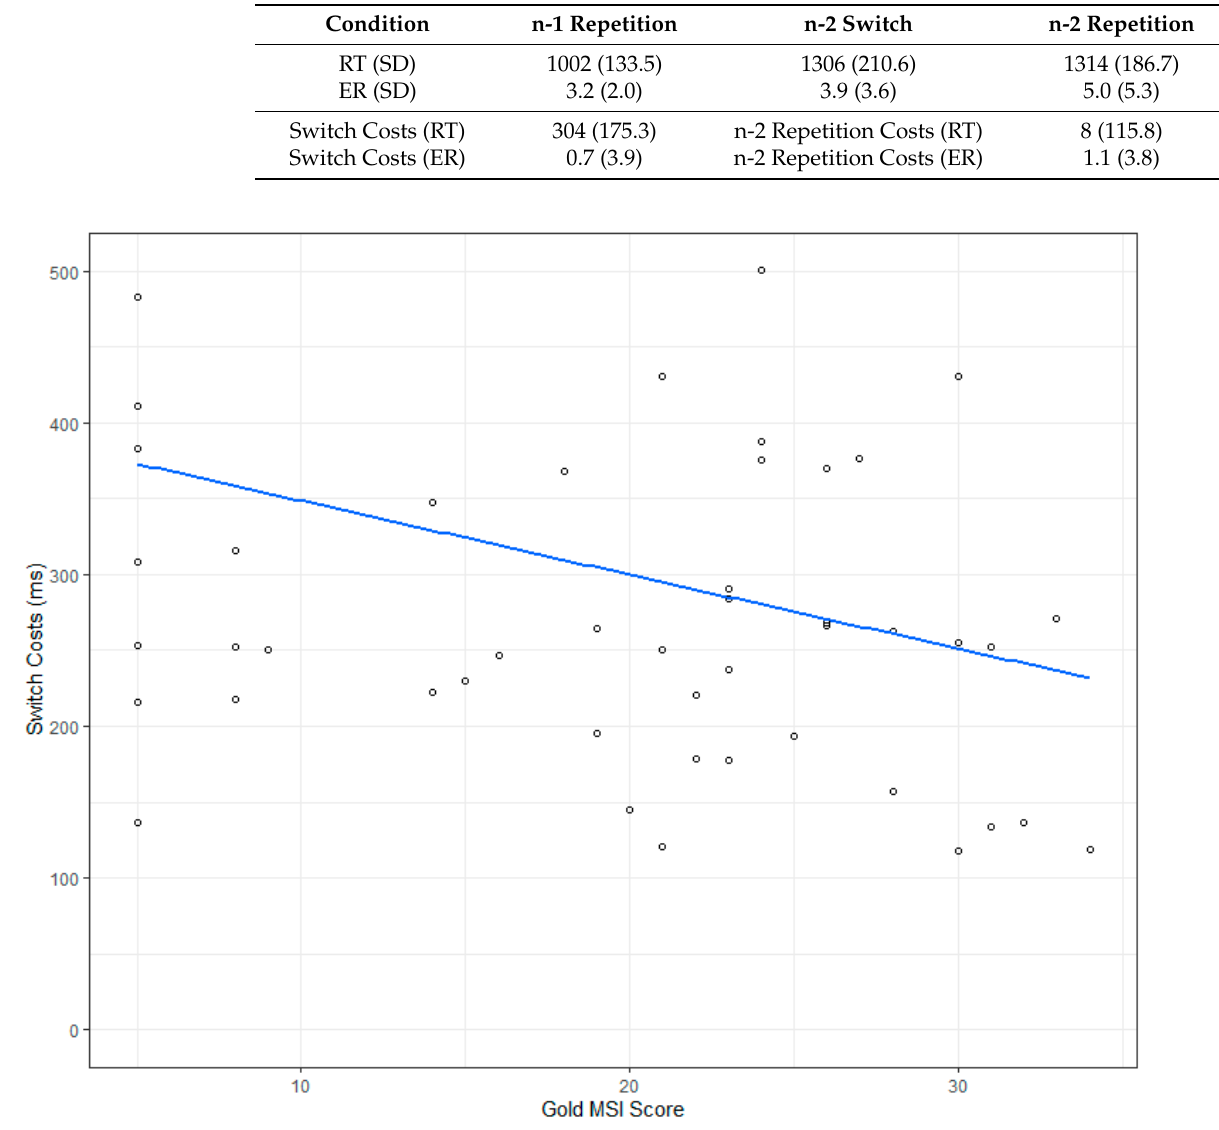
Figure 2. Switch costs (ms) by Gold MSI score obtained. The blue line is the fitted regression line.